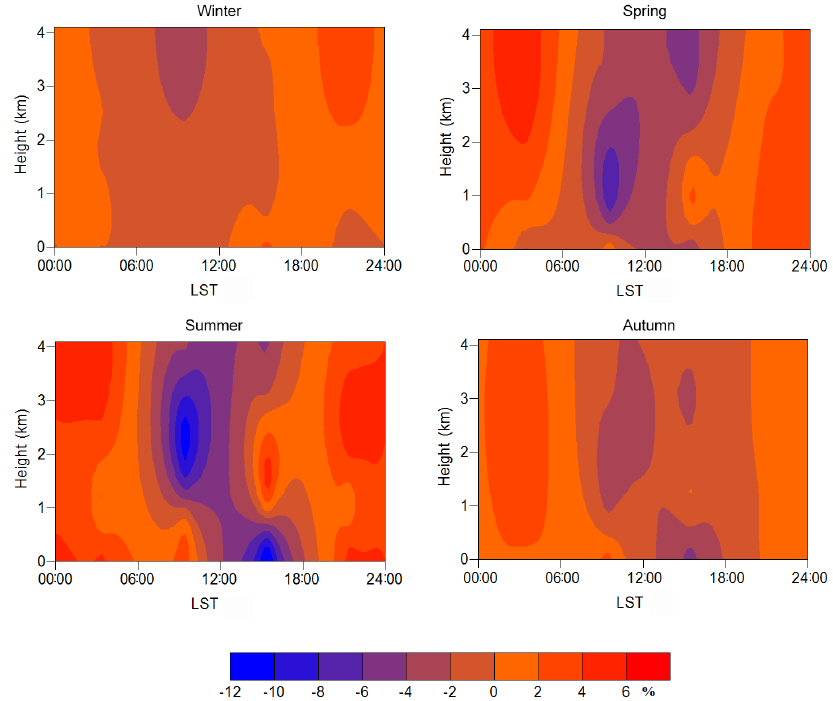
Figure 4. Mean diurnal anomalies of water vapor density (percentage of daily mean at each level) for SAMR station according to ERA- Interim reanalysis data in the period